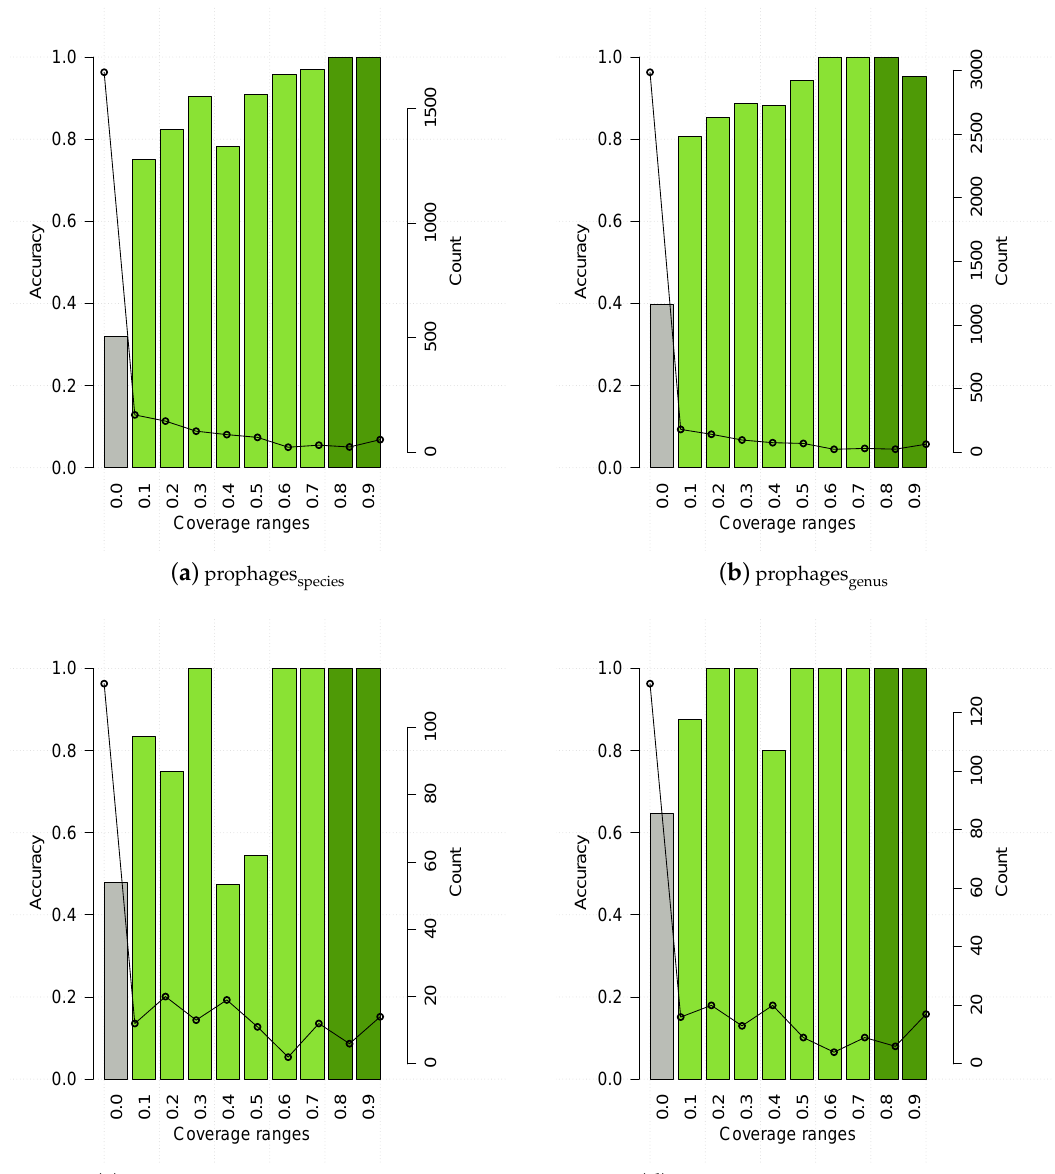
Figure 8. HostPhinder’s accuracy (bar) and prediction counts (line) on prophages predicted by PhySpy, upper panels, and manually verified prophages, lower panels, at different coverage ranges. The values displayed on the x axis are the lower limit of that range. With exception of the last bin which includes all entries with coverage >0.9, all ranges are right-closed with upper limit x + 0.1. Poorly reliable results are in grey, while reliable and highly reliable results are in green and dark green